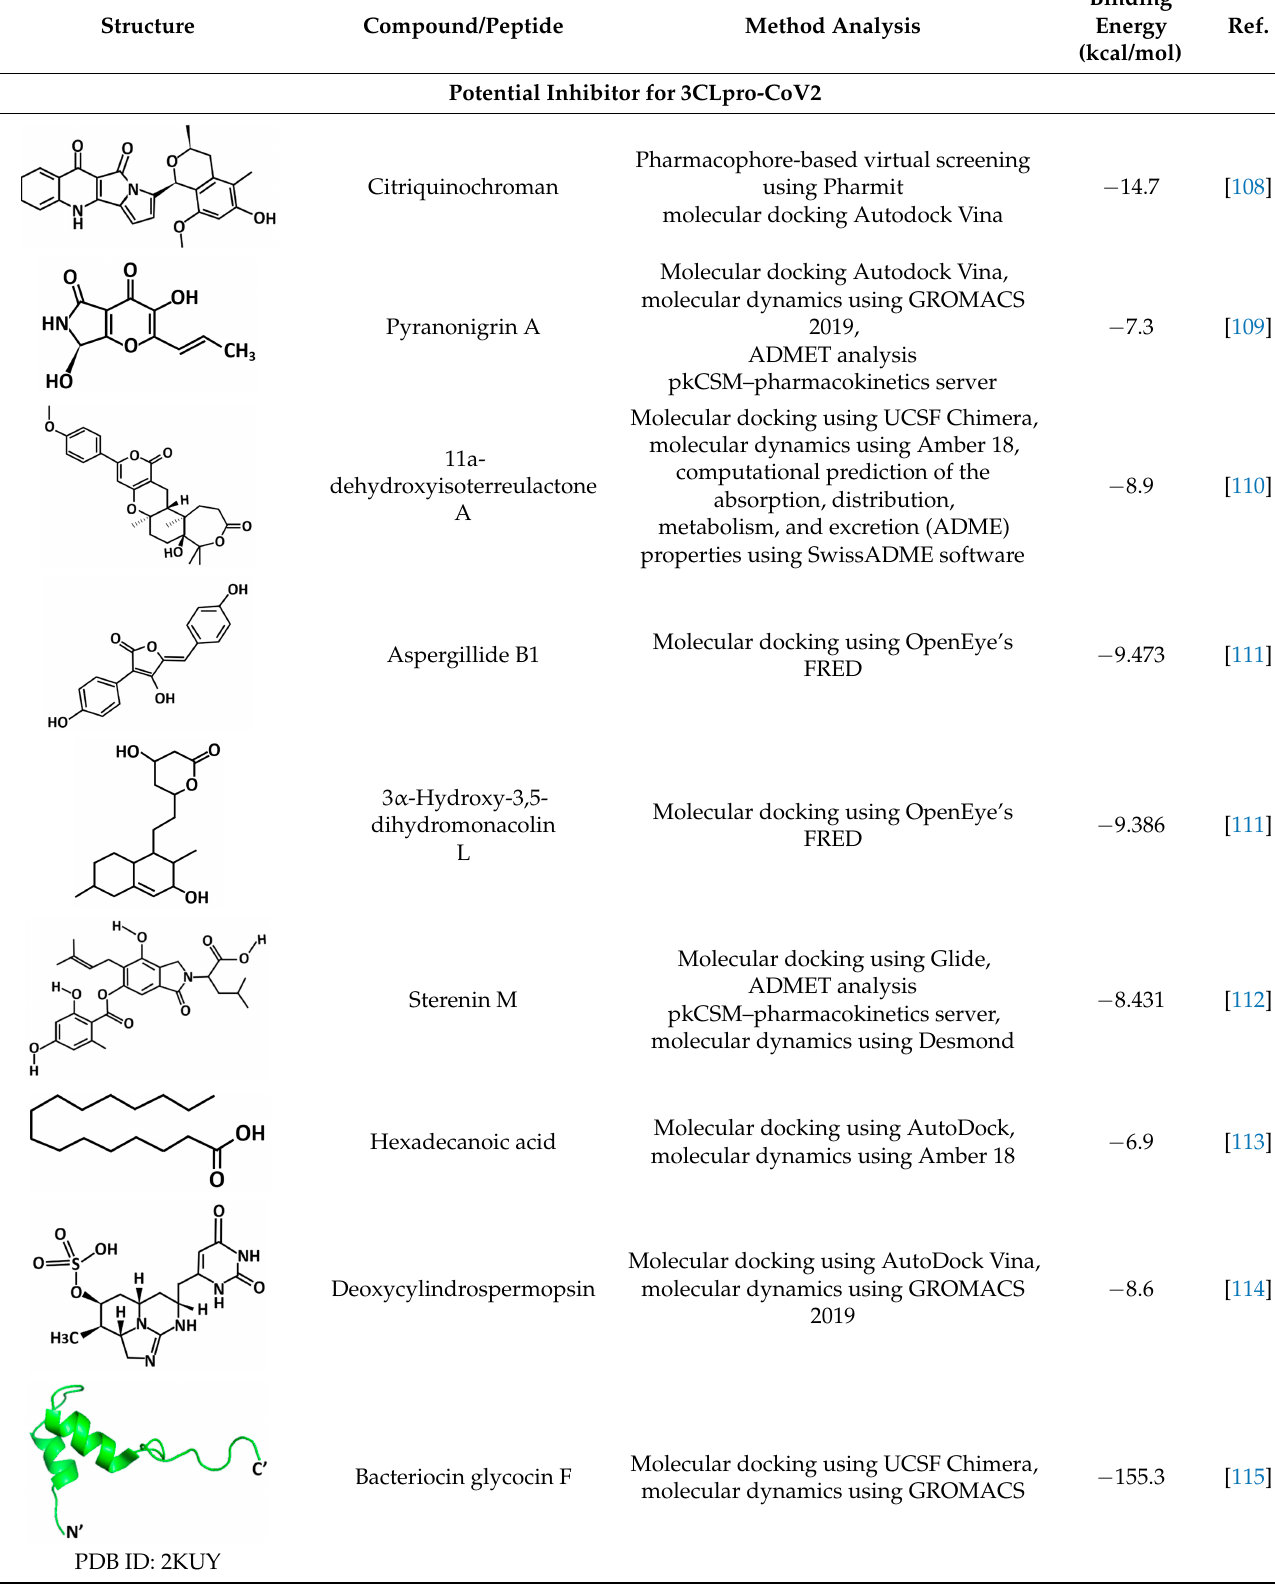
Table 2. List of the highest potential inhibitors from microbial sources for SARS-CoV-2 proteases with their binding energy. Structure